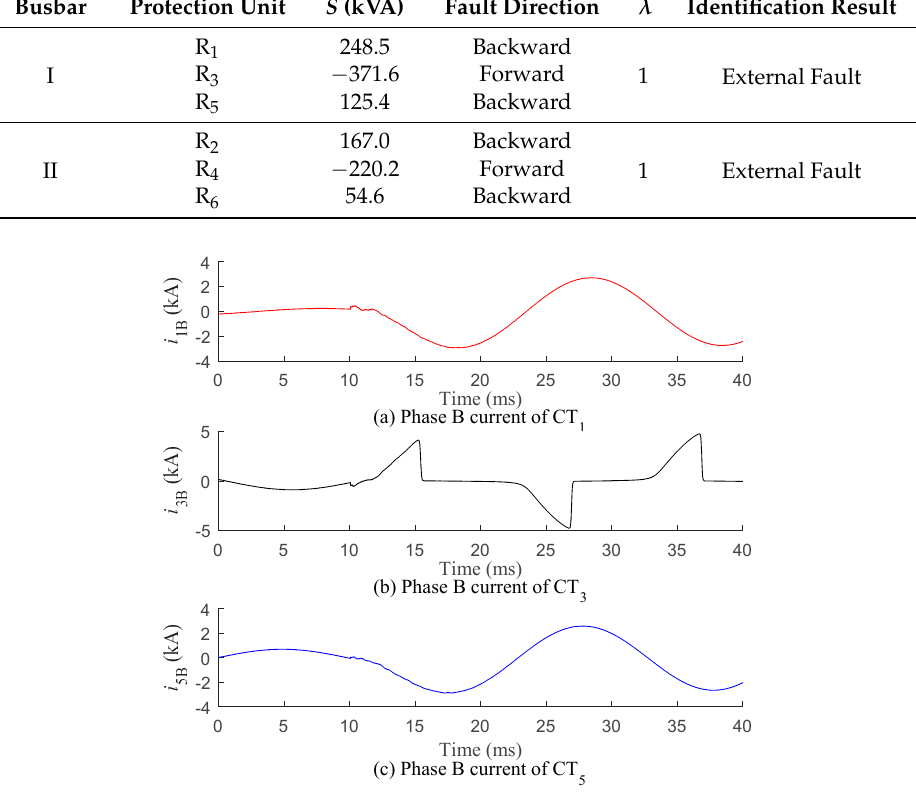
Table 9. Simulation results for a phase B fault on l 3 .